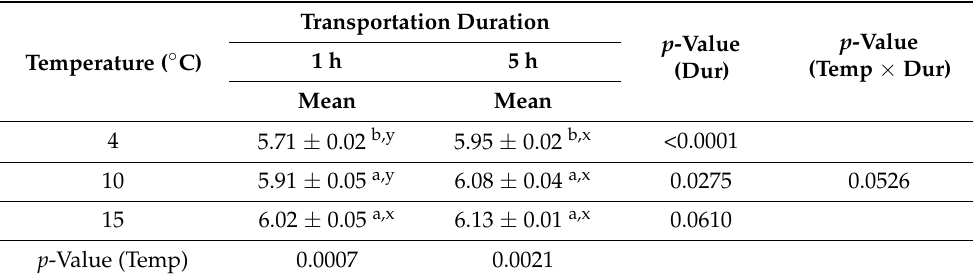
Table 6. Effects of transportation temperatures (4 ◦ C, 10 ◦ C, and 15 ◦ C) for two different transportation durations (1 and 5 h) on the coliform population (log 10 ) of pectoralis major muscles in broiler chickens.